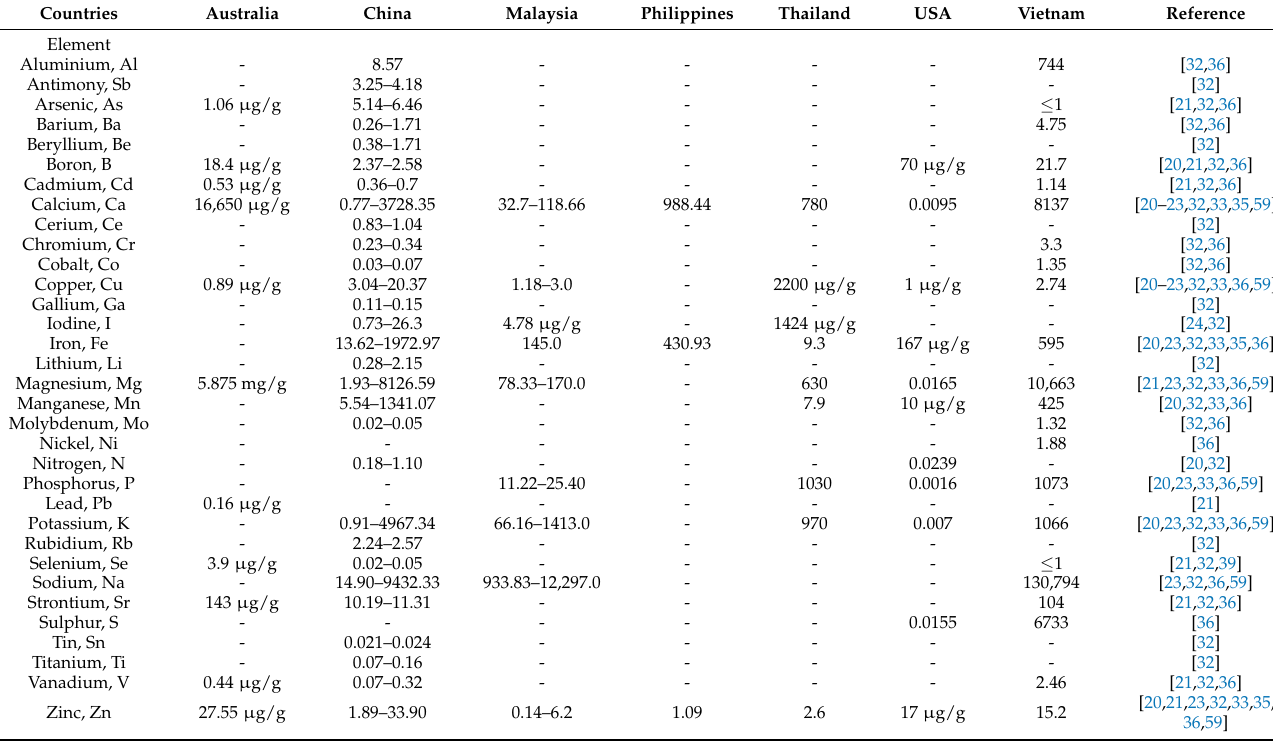
Table 4. Mineral element composition in C. lentillifera in different